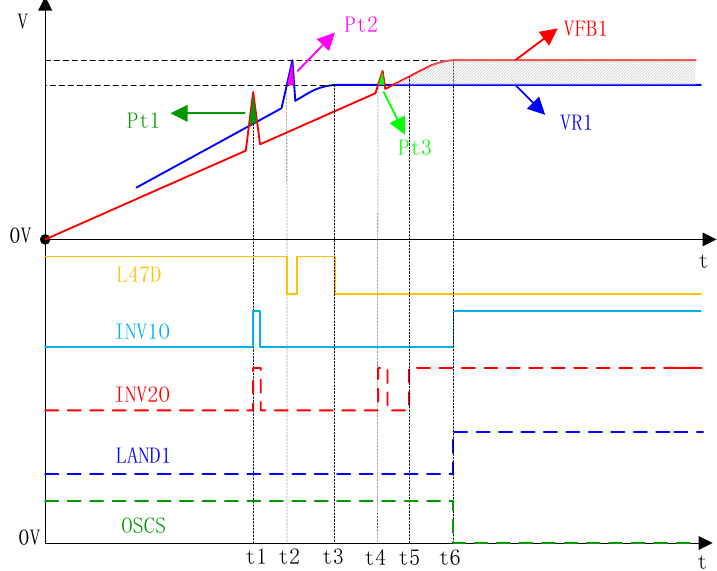
Figure 6. Logic schematic of OSCS